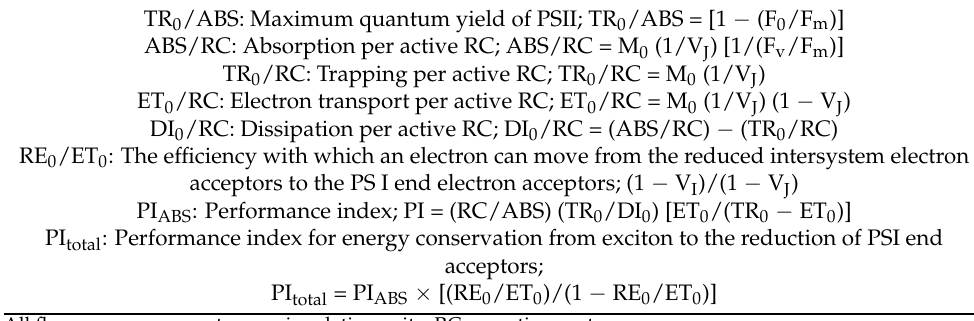
Table 1. Parameters and formulae used in the analysis of the OJIP fluorescence transient. TR 0 /ABS: Maximum quantum yield of PSII; TR 0 /ABS = [1 − (F 0 /F m )] ABS/RC: Absorption per active RC; ABS/RC = M 0 (1/V J ) [1/(F v /F m